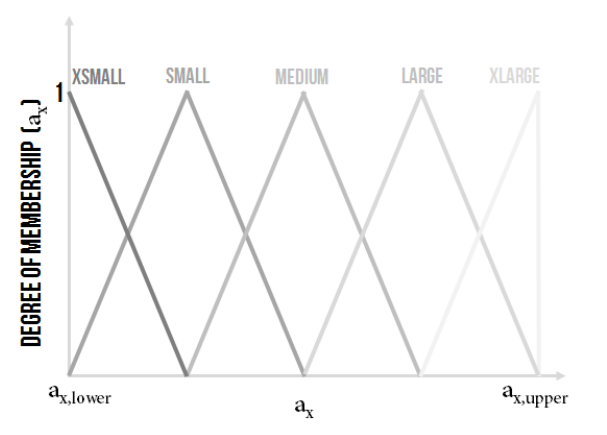
Figure 10. The shape of the membership functions of linguistic values for the input linguistic variable a 2 , a 1 and a 0